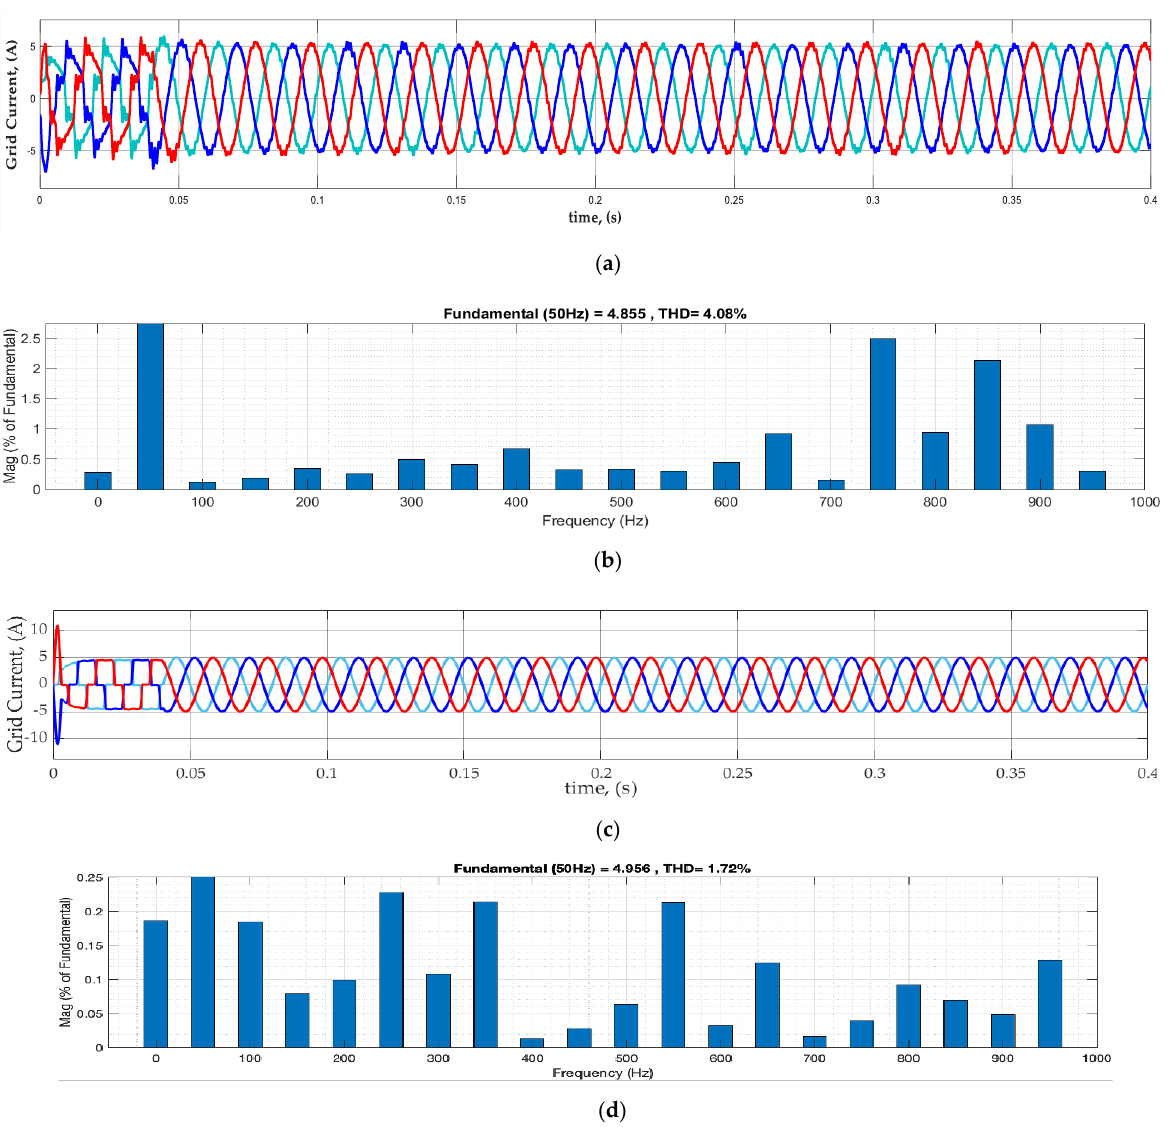
Figure 8. Grid current and the THD after HPF. ( a ) Grid current waveform after a PI-controlled HPF addition, ( b ) THD after PI controlled HPF has been added to the filter, ( c ) the grid current output wave shape after incorporating the fuzzy-tuned PI controller into the HPF circuit, and ( d ) the THD of the fuzzy-assisted PI controlled HPF.